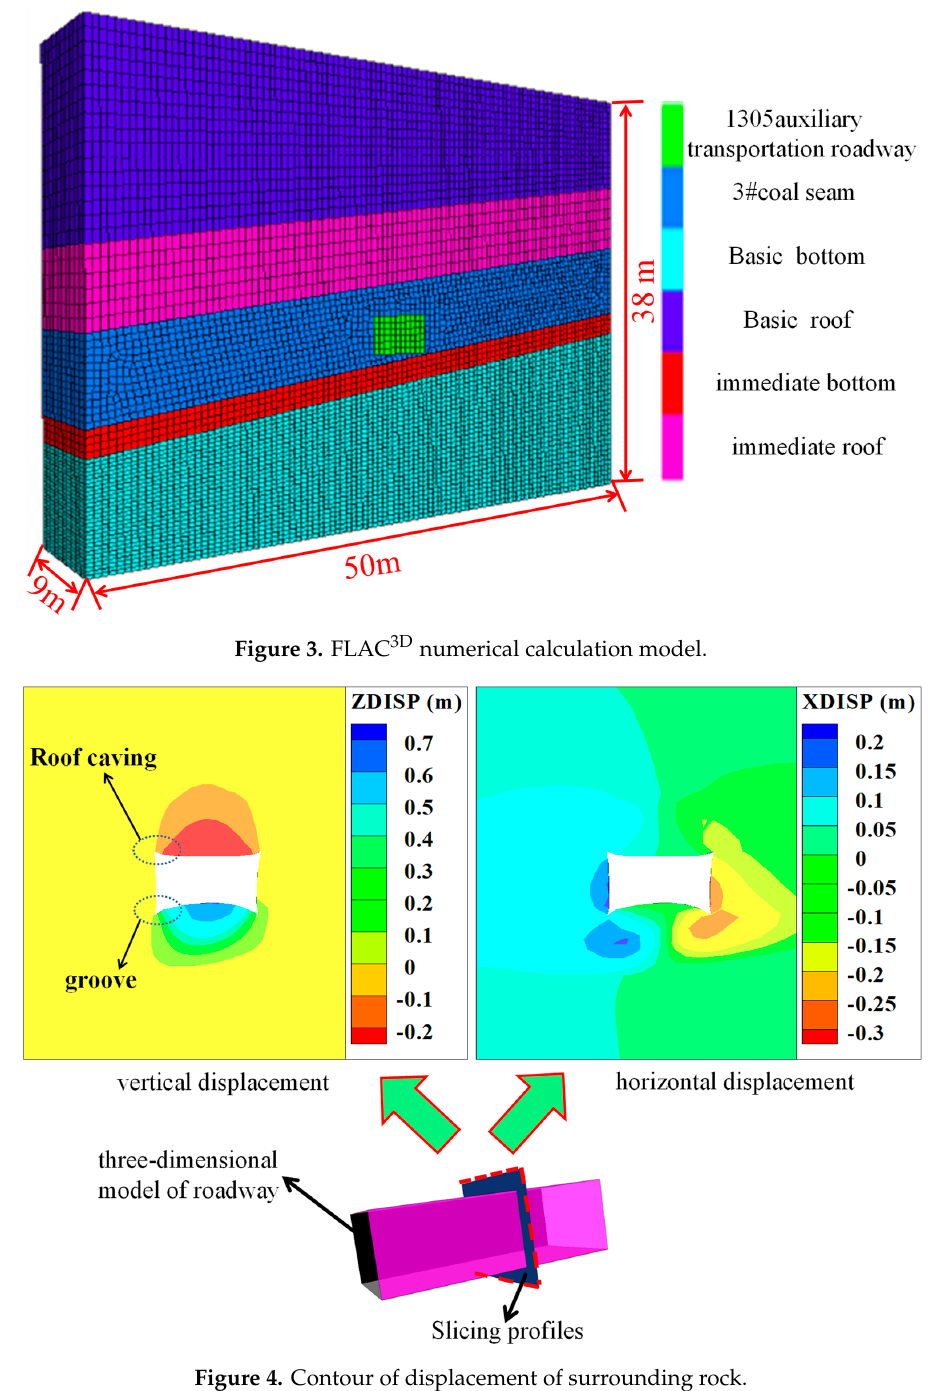
Figure 4. Contour of displacement of surrounding